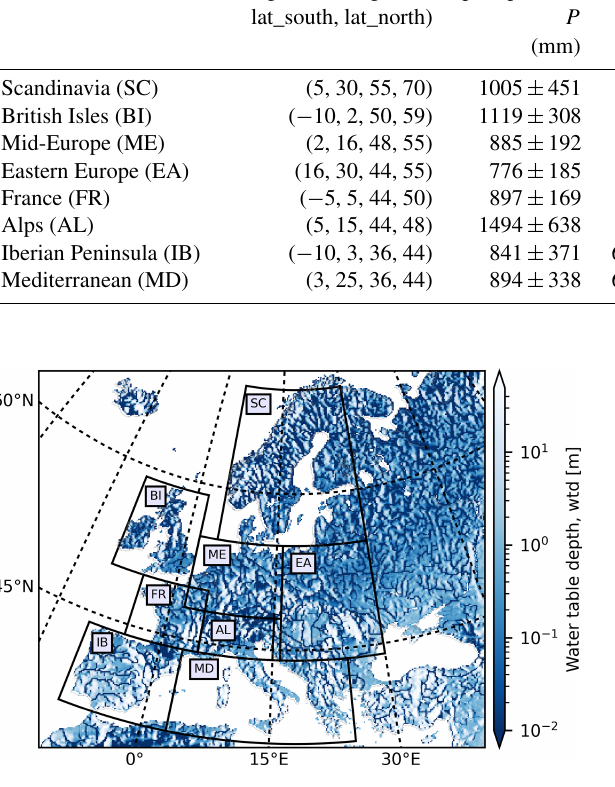
Figure 3. TSMP-G2A wtd (meters) climatology over the European continent for the time period from 1996 to 2016. Areas bounded by the thick black lines show the PRUDENCE regions (i.e., SC – Scandinavia; BI – British Isles; ME – mid-Europe; EA – Eastern Europe; FR – France; AL – Alps; IB – Iberian Peninsula; MD –